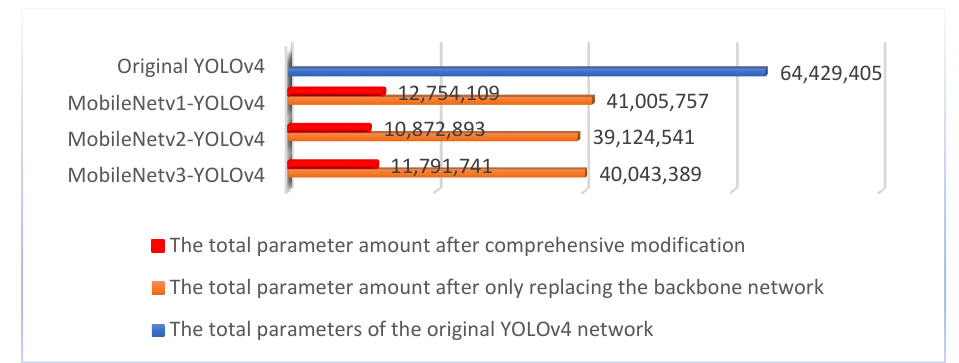
Figure 9. The depthwise separable convolutions are used to replace the standard convolutions in SPP and PANet.